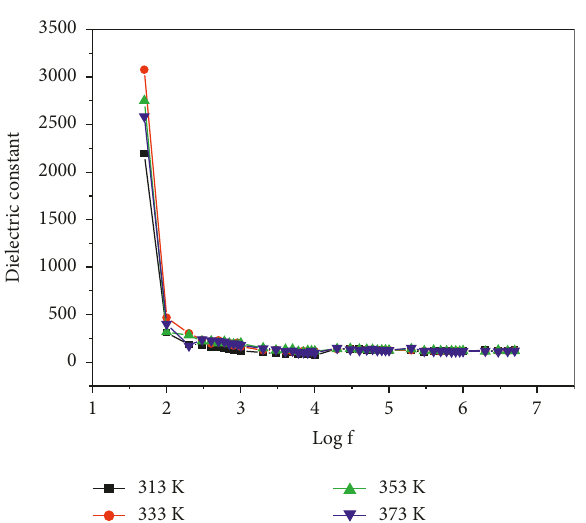
Figure 3: Dielectric constant vs log F of